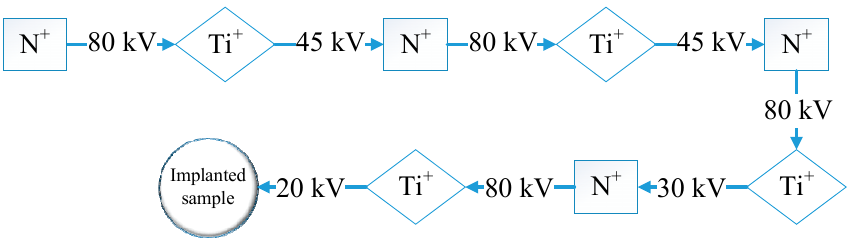
Figure 1. The fabricating process of N + + Ti + ion implantation for M50 steel. Table 2. Processing parameters of N + and Ti + bi-ion implantation. Implantation Parameter Implantation